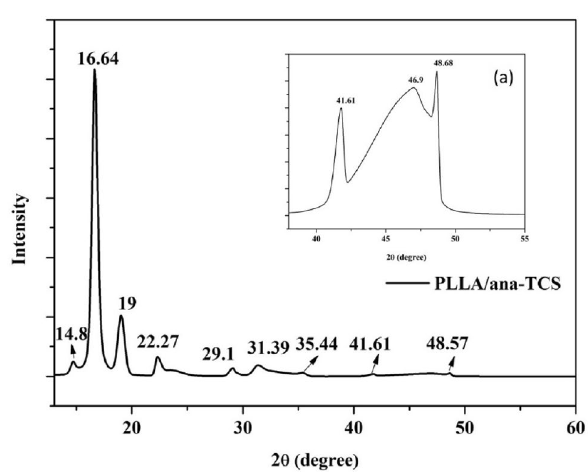
Figure 2. 1 H NMR spectrum of PLLA-g-ana TCS, showing a magnified area within the range of 4.5–1.9 ppm.